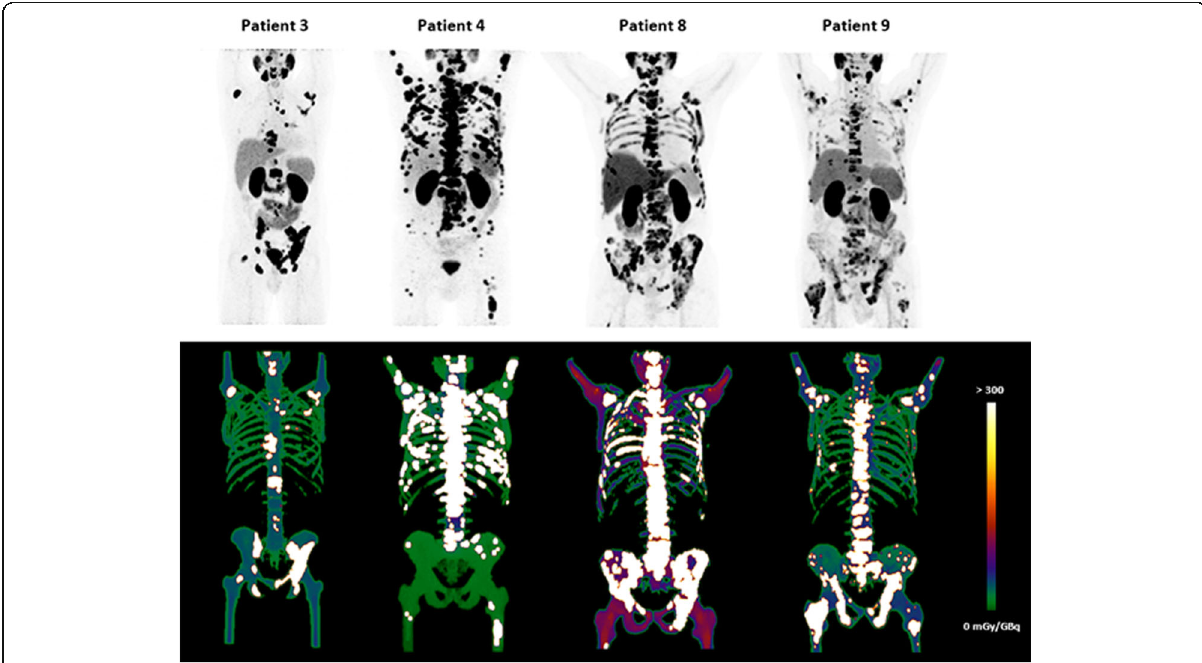
Fig. 3 Exemplary Monte Carlo simulation results for patients 3, 4, 8, and 9. Upper row: MIP from pre-therapeutic Ga-68- PSMA-11 PET/CT; lower row: MIP for simulated absorbed dose within the bone